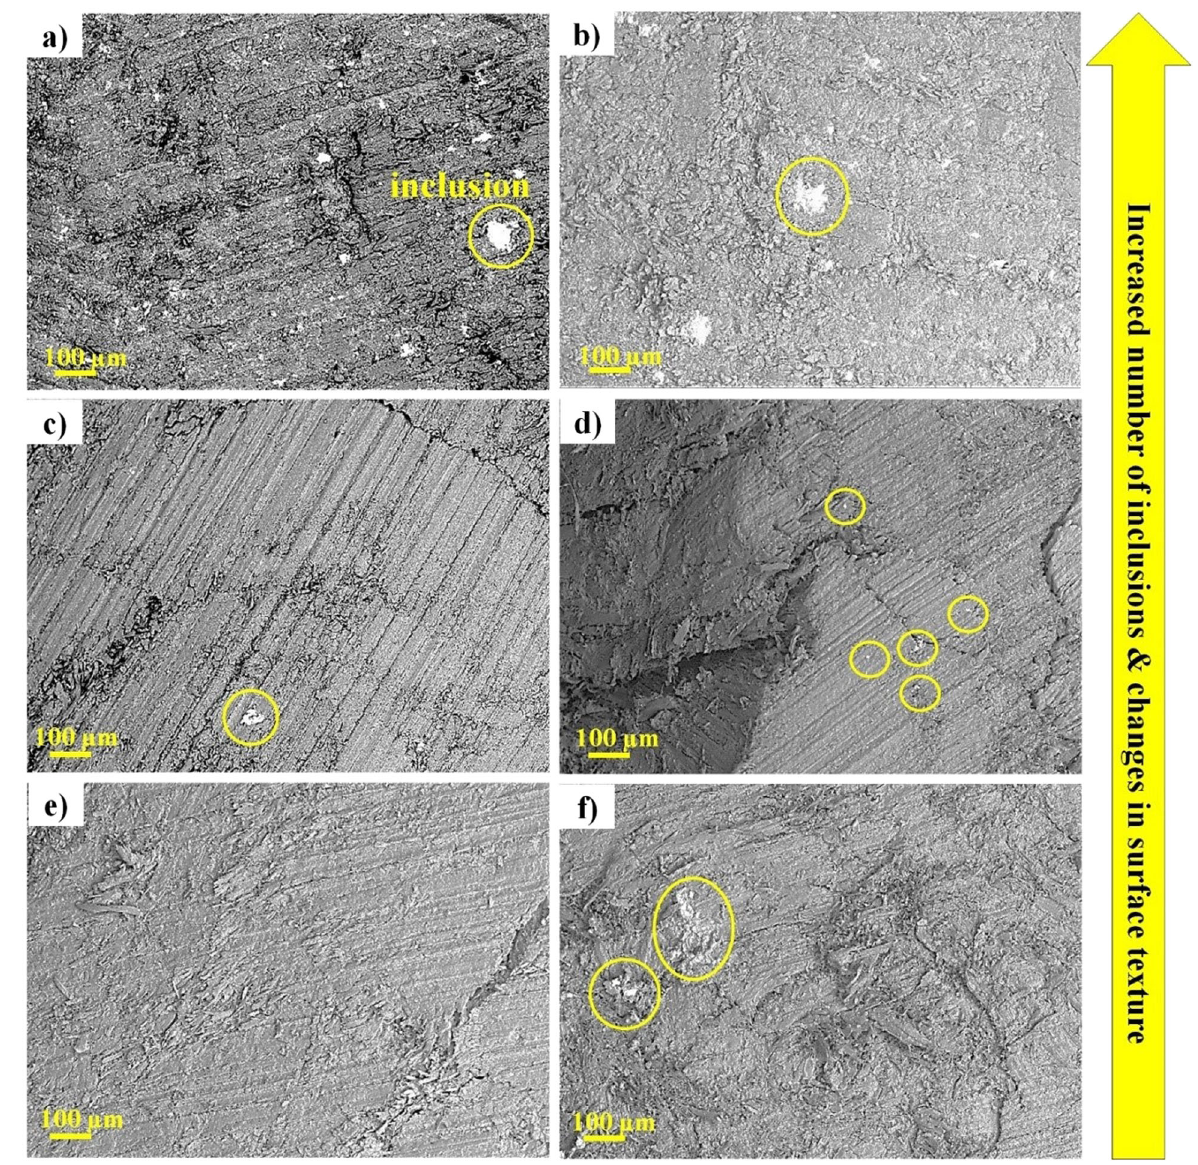
Fig. 4 SEM images of samples #4 at region 1 before and after storage. a , b Torre fi ed pellet (tor_sample4) before storage ( a ) and after 1 month of storage ( b ). c , d Wood pellet type I (wp1_sample4) before storage ( c ) and after 1 month of storage ( d ). e , f Wood pellet type II (wp2_sample4) before storage ( e ) and after 1 month of storage ( f ). Yellow circles indicate example inclusions detected at the surface of the